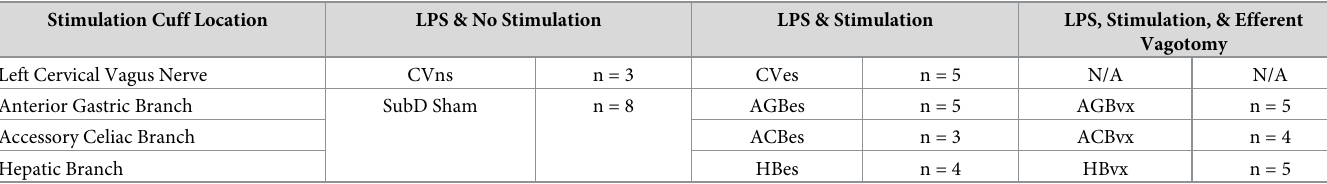
Table 1. Overview of subgroups used for acute electrical stimulation